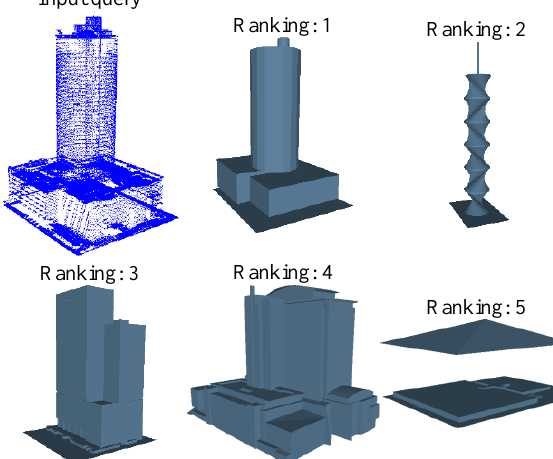
Figure 12. Retrieval results of the proposed method.